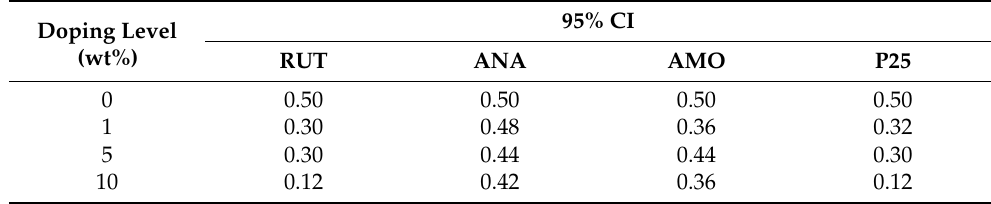
Figure 4. Plots of V sat versus relative humidity for PES films doped with 1 wt% ( a ), 5 wt% ( b ), and 10 wt% ( c ) RUT nanoparticles. 10 wt% ( c ) RUT nanoparticles. Table 1. Values of 95% CI for PES films doped with 0, 1, 5, and 10 wt% TiO 2 Table 1. Values of 95% CI for PES films doped with 0, 1, 5, and 10 wt% TiO 2 .